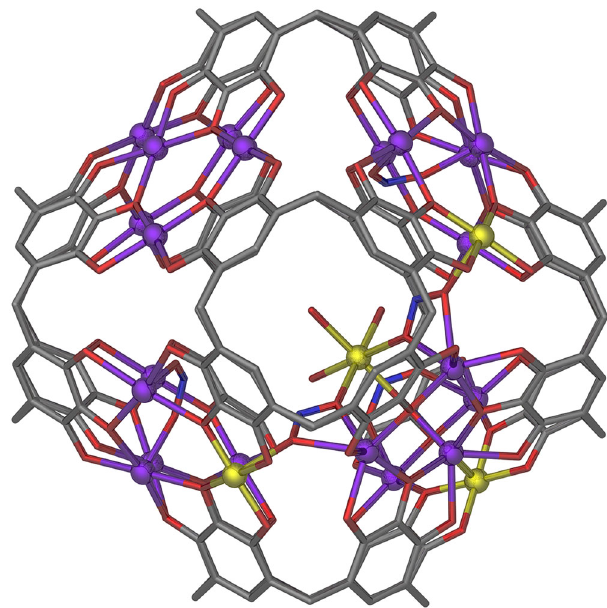
Fig. 1 Symmetry expanded single-crystal X-ray structure of 1 . A view of 1 showing the seam of manganese ions, as well as the additional encapsulated manganese ion. Disordered PgC 5 alkyl chains, some axial ligands, and H atoms have been removed for clarity. Color code: Mn II — purple, Mn III — yellow, N — blue, O — red, and C —